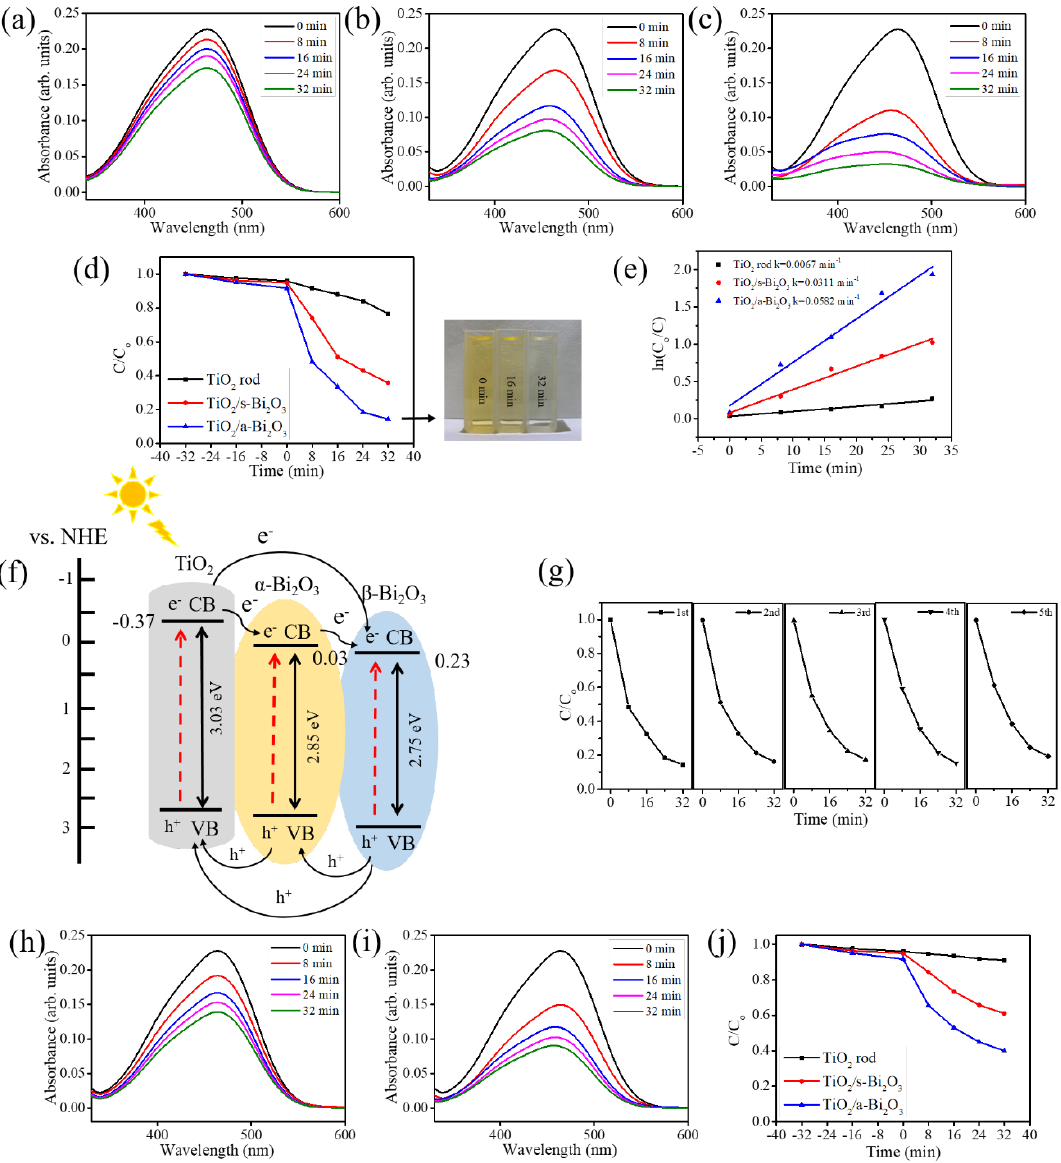
Figure 8. The irradiation duration dependent absorption spectra of the methylene orange (MO) solution containing various rod samples: ( a ) TiO 2 rods, ( b ) TiO 2 /s – Bi 2 O 3 rods, ( c ) TiO 2 /a – Bi 2 O 3 rods. ( d ) C / C o versus irradiation duration plot. The insets show the discoloration of the MO solution containing the TiO 2 /a – Bi 2 O 3 rods under various irradiation durations. ( e ) ln ( C o / C ) versus irradiation duration plot. ( f ) The possible band alignments of the TiO 2 /a – Bi 2 O 3 composite structure. ( g ) Recycling photodegradation tests of the MO solution containing TiO 2 /a – Bi 2 O 3 composite rods under irradiation. The visible light irradiation time-dependent absorbance spectra intensity variation of the MO solution containing ( h ) TiO 2 /s – Bi 2 O 3 and ( i )TiO 2 /a – Bi 2 O 3 photocatalysts. ( j ) C / C o vs. visible light irradiation duration plots of the MO solution containing various composite rods.